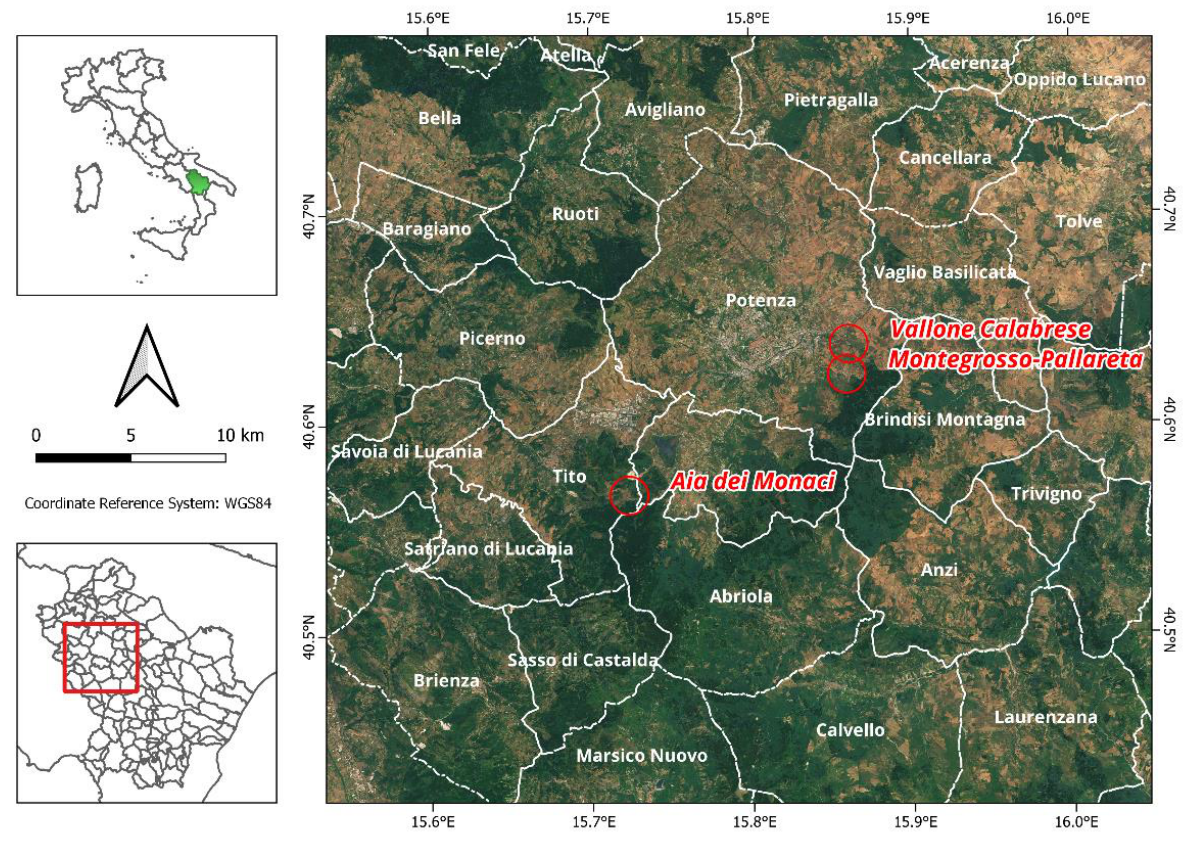
Figure 1. Overview of the study areas on “Sentinel-2 cloudless—https://s2maps.eu (accessed on 14 November 2021) by EOX IT Services GmbH (Contains modified Copernicus Sentinel data 2017 & 2018)”.